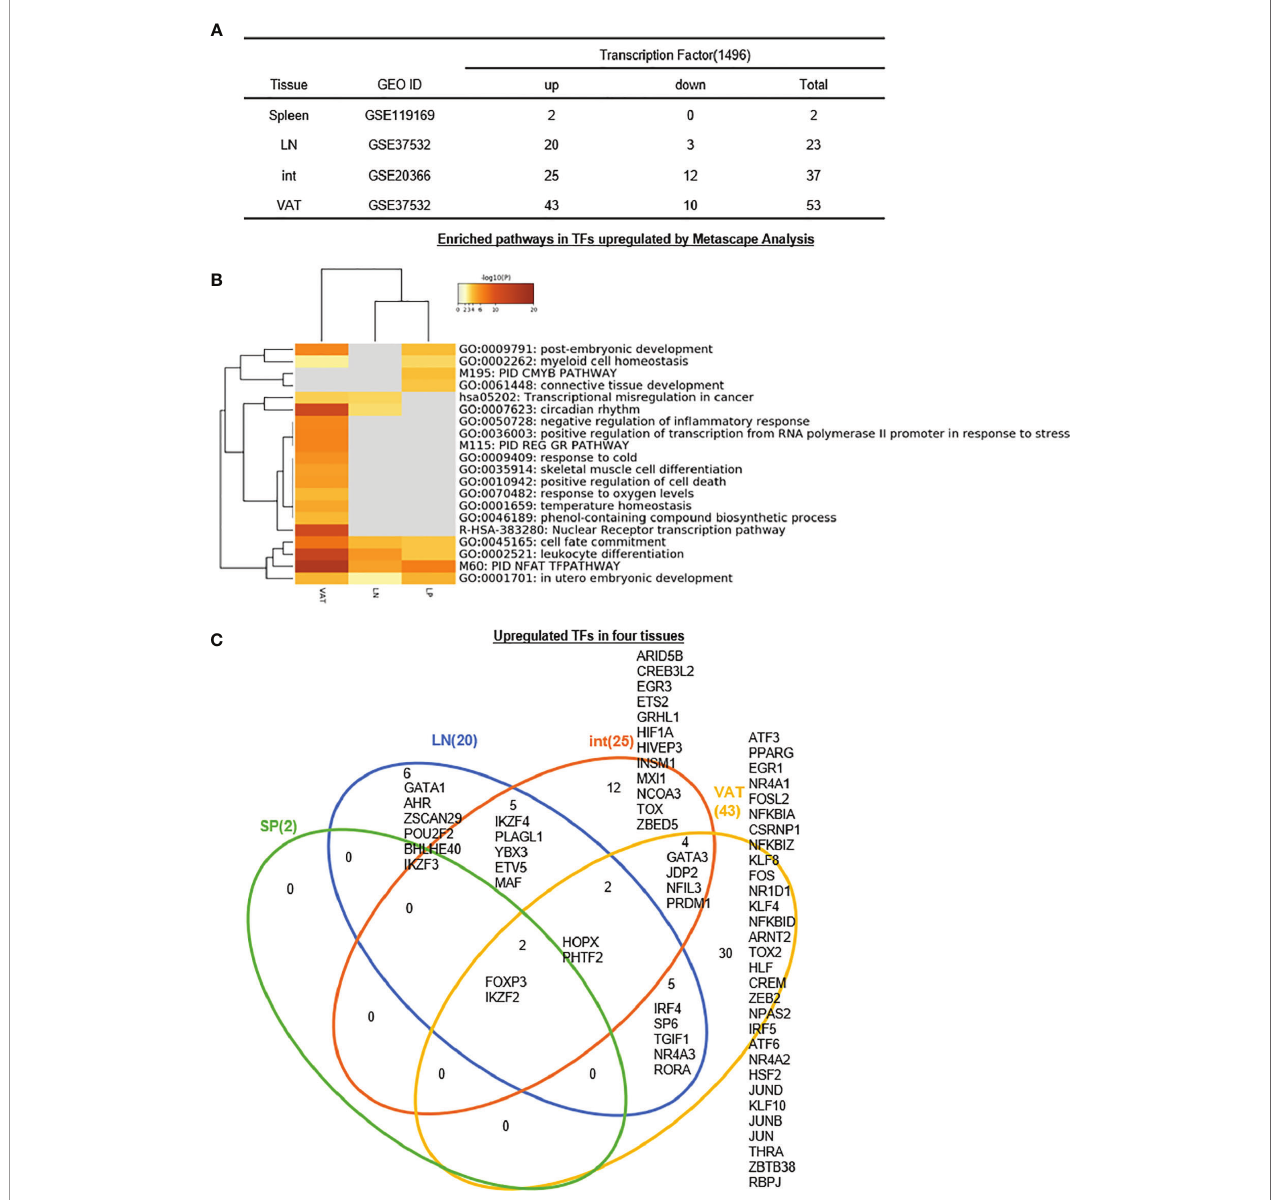
FIGURE 8 | (A – C) Six LN Treg speci fi c transcription factors (TFs), 12 intestine Treg-speci fi c TFs, and 30 VAT Treg-speci fi c TFs are identi fi ed, which mediate 20 immune signaling pathways after screening for total 1,496 TFs. The original gene lists were all obtained according to the leading program the Human Protein Atlas (HPA, https://www.proteinatlas.org/). See the detailed data in Supplementary Figure 7